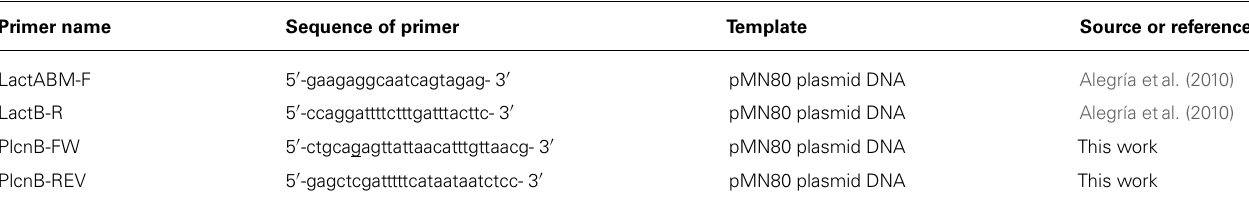
Table 3 | Sequence of specific primers used in this